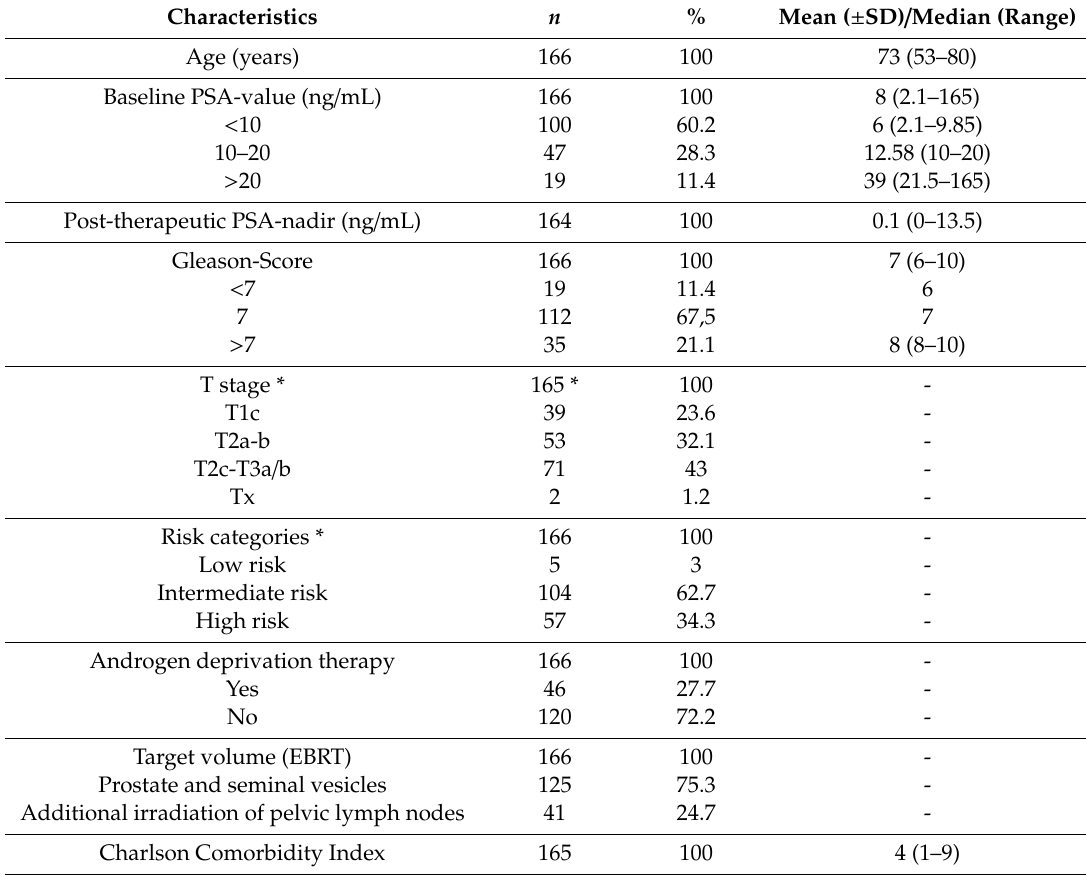
Table 1. Patient